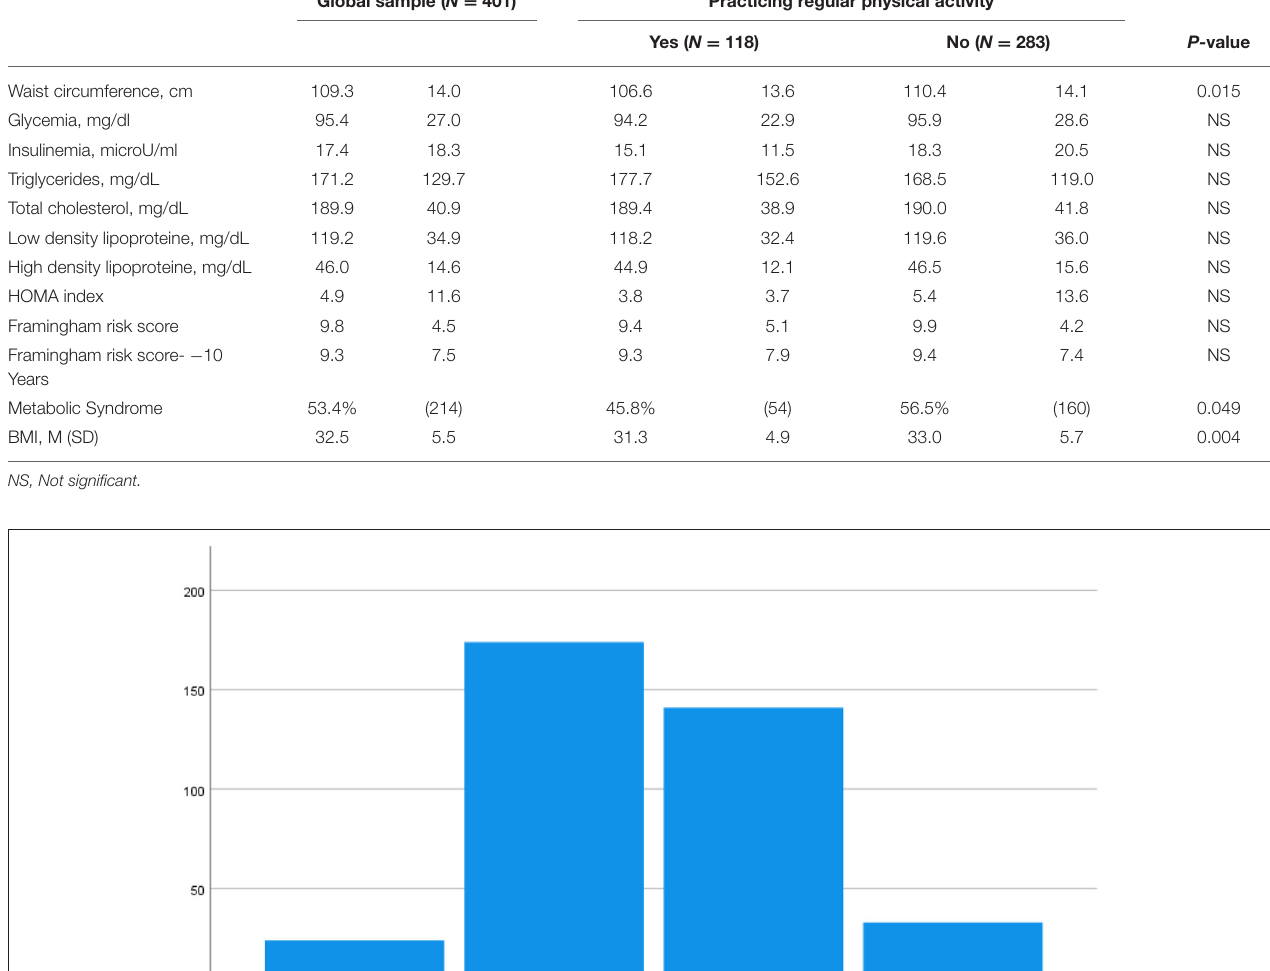
Patients performing regular physical activities have lower levels of anergia (7.0 ± 3.2 vs. 8.1 ± 2.8, p < 0.001) and hostility (4.2 ± 1.9 vs. 3.7 ± 1.5, p < 0.001) at the BPRS